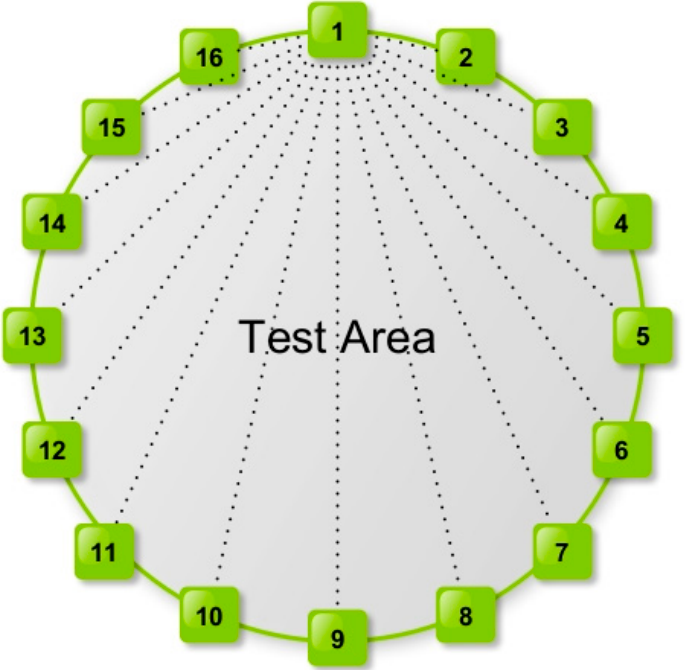
Figure 7. Symbolic representation of the measurement cycle performed by a single probe in the presented radio tomograph.